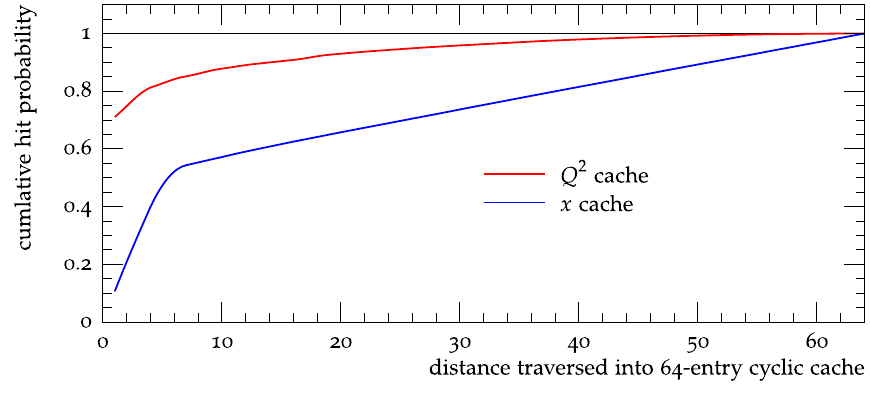
of obtaining cache-hit as a function of search depth into a 64-entry cyclic cache for calls to x and Q 2 by S HERPA when generating e + e − +jet MC